Question: Produce a descriptive caption suitable for publication.
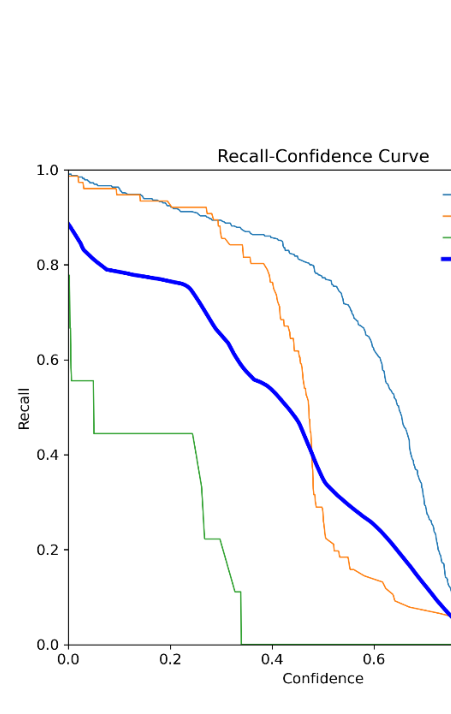
Answer: YOLOv8 Recall - Confidence curve